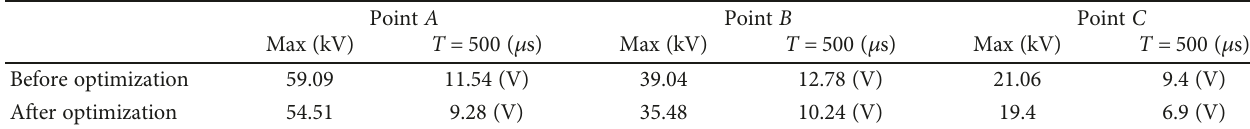
Table 2: Simulation data comparison before and after optimization in irregular grounding